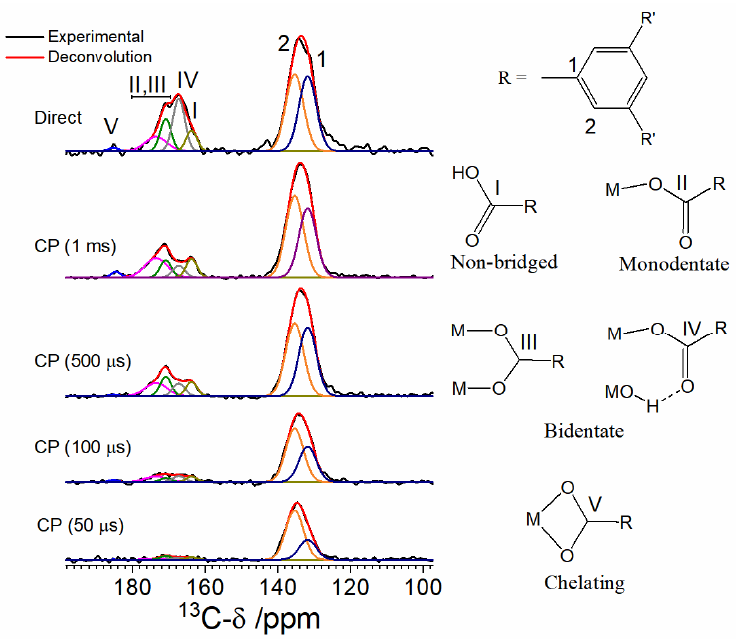
Figure 4. ( Left ): 13 C MAS NMR spectra (black curves) obtained by 13 C{ 1 H} cross-polarization (CP) and direct polarization on 13 C with background suppression and 1 H decoupling (Direct). Colored curves are spectral deconvolutions into Gaussian functions. Assignments for the observed peaks are given as roman numerals, corresponding to the scheme on the right. Assignments for species II and III could not be unequivocally provided, both lies in the region indicated by an horizontal line in the figure. ( Right ): Possible coordination modes for the carboxylate groups in btc with the metallic species. R’ is a carboxylate group in one of the coordination modes I to V.